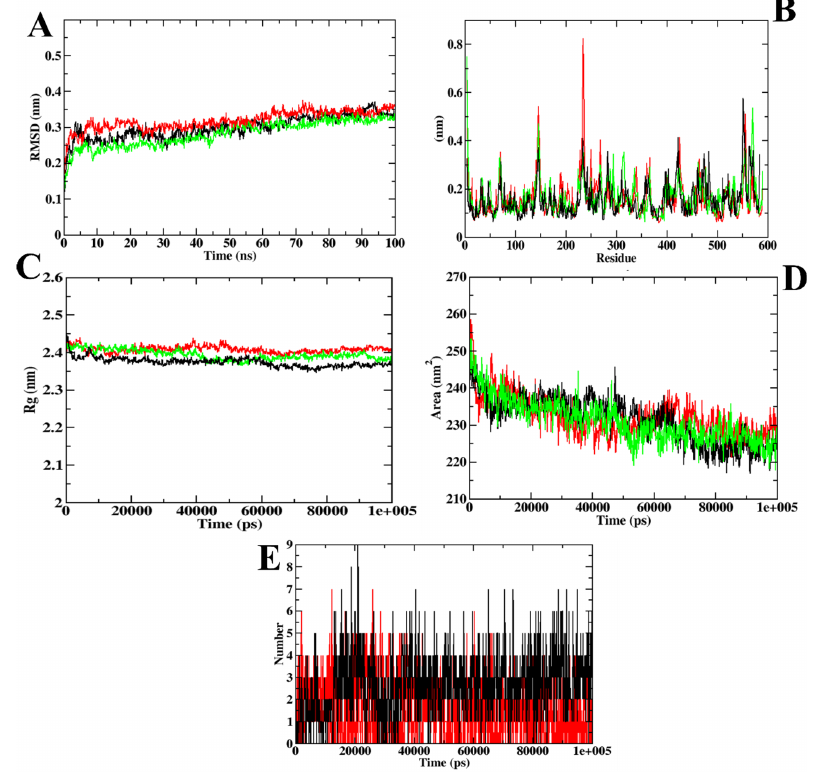
Figure 3. Visualization of MD trajectories obtained for CD-59 and acarbose complexed with α -glucosidase; ( A ) RMSD, ( B ) RMSF, ( C ) Rg, ( D ) SASA, and ( E ) SASA. Green: apoprotein, red: protein–acarbose complex, and black: protein–CD-59 complex.